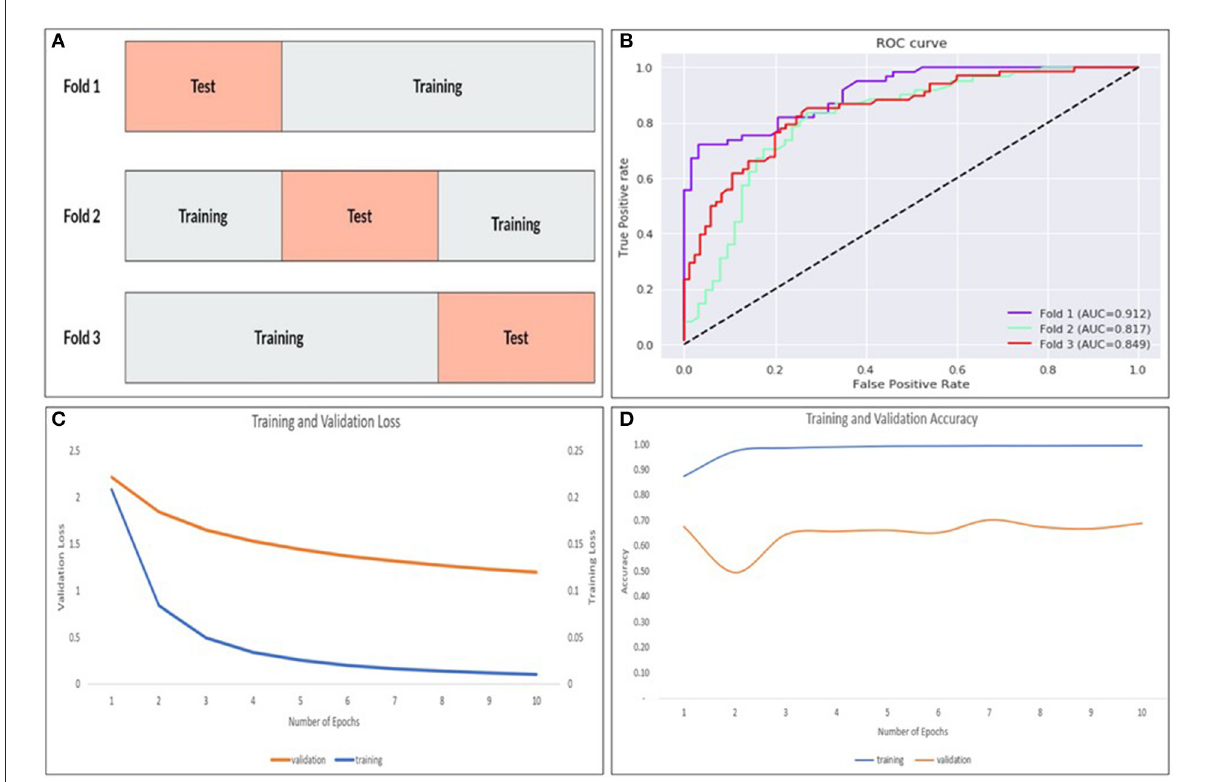
FIGURE7 The k-fold cross validation architecture with the data partitioned into training and tests sets for k = 3–folds (A) , AUROC curves for each fold (B) as well as training/validation loss (C) and training/validation accuracy (D) for the model.